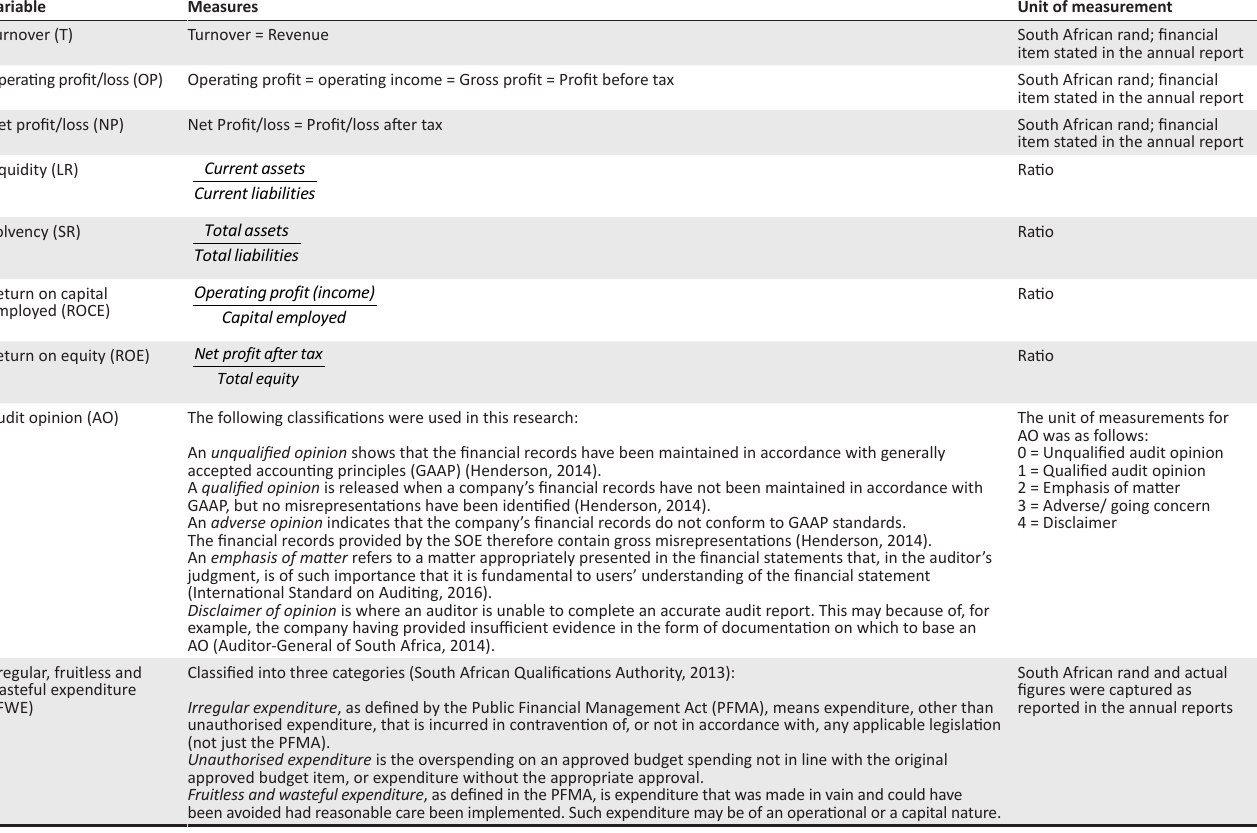
TABLE 2: Measurement of independent